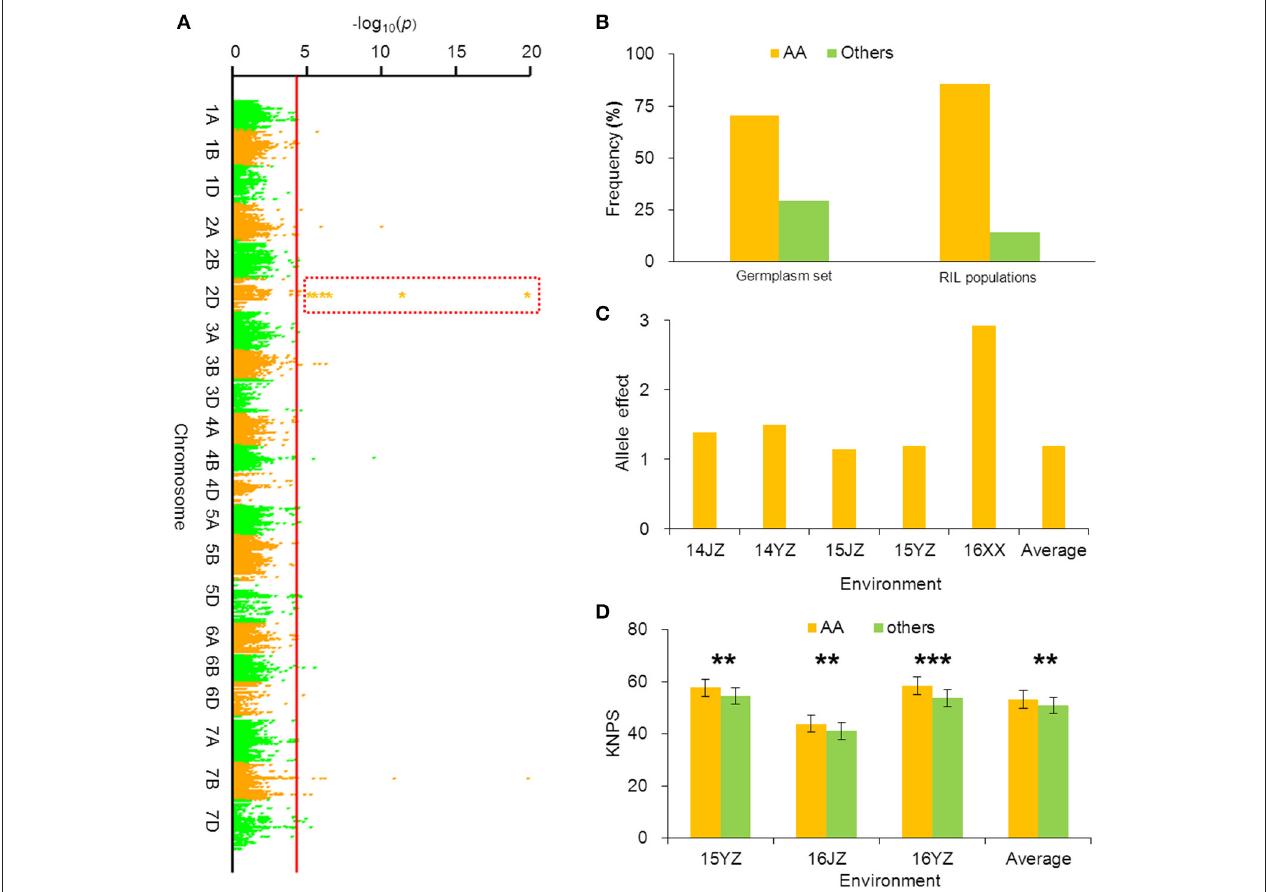
FIGURE 3 | Favorable allele BobWhite_c10539_201-2D AA associated with KNPS and analysis of its effect. (A) Markers associated with KNPS were identified by a mixed linear model in the germplasm set. The orange dots in the red frame show the association signals across all environments ( P < 4.99 × 10 − 5 ). (B) Allelic frequencies ( AA vs. aa ) in the germplasm set and RIL population. Orange histogram represents the favorable allele. (C) Genetic effect of BobWhite_c10539_201-2D AA in the germplasm set grown in different environments. (D) Genetic effects of BobWhite_c10539_201-2D AA in the RIL population grown in different environments. ** P = 0.01; *** P =